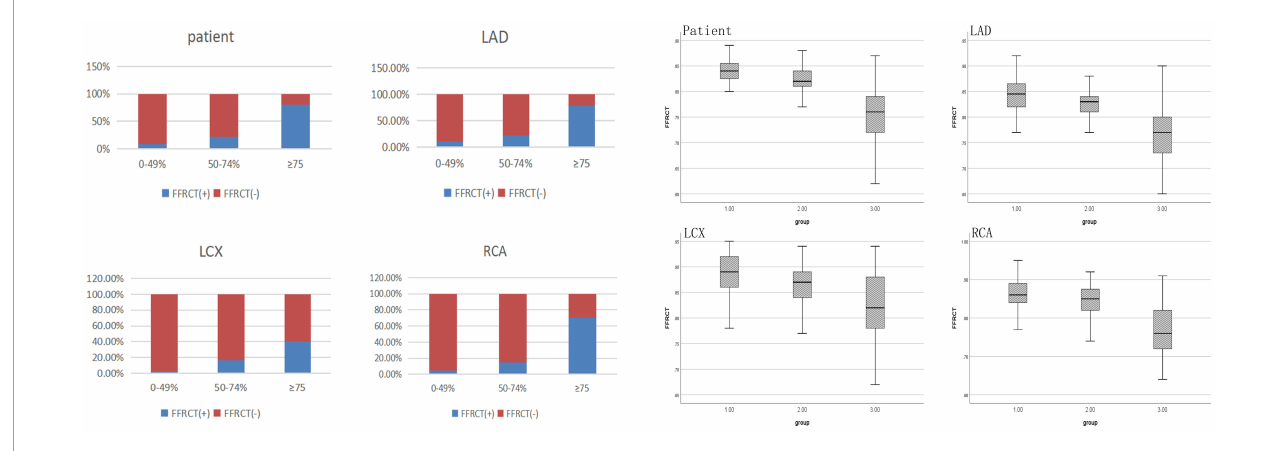
FIGURE2 FFRCT values of coronary arteries with different degrees of stenosis in invasive coronary angiography.